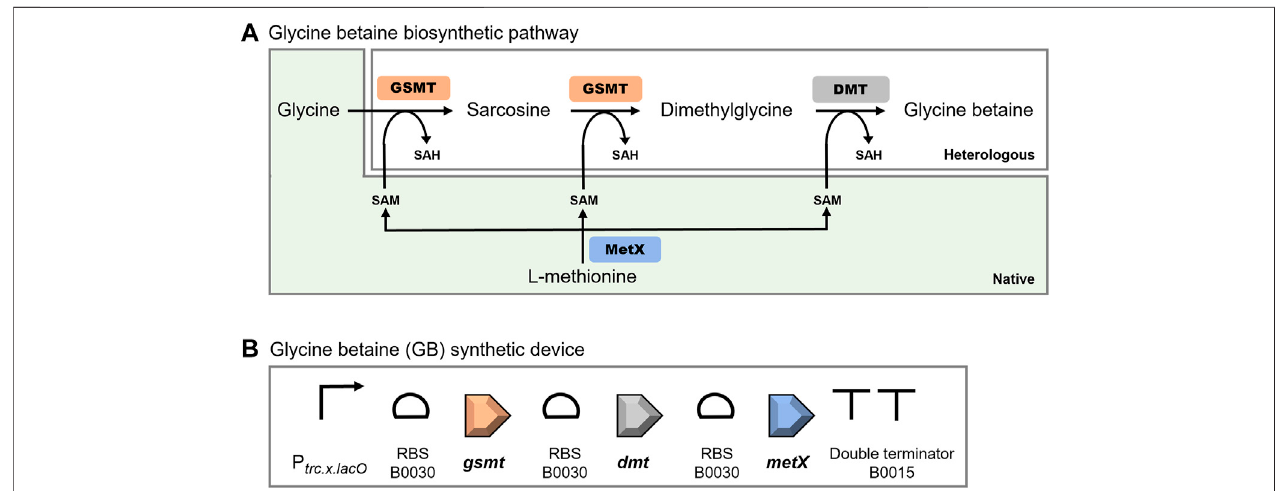
FIGURE 5 | Glycine betaine biosynthetic pathway (A) and schematic representation of the glycine betaine (GB) synthetic device for the production of this heterologouscompatible solute in Synechocystis (B) .Theglycinebetaine biosynthetic pathwaycomprisestheGSMT(glycine-sarcosine- N -methyltransferase) andDMT (dimethylglycine- N -methyltransferase) from Aphanothece halophytica (heterologous), and MetX ( S -adenosyl-methionine synthase) from Synechocystis (native). SAM — S -adenosyl-methionine; SAH — S -adenosyl-homocysteine. The GB device includes the promoter P trc.x.lacO , the ribosomal binding site (RBS) B0030, the open reading frames gsmt , dmt , and metX codon optimized for Synechocystis , and the double terminator B0015.